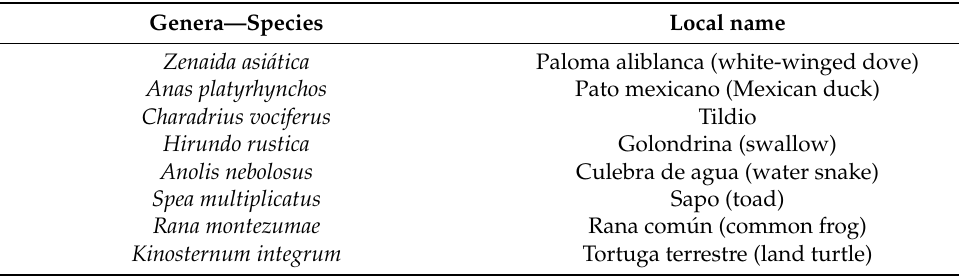
Table 5. Typification of fauna in the study